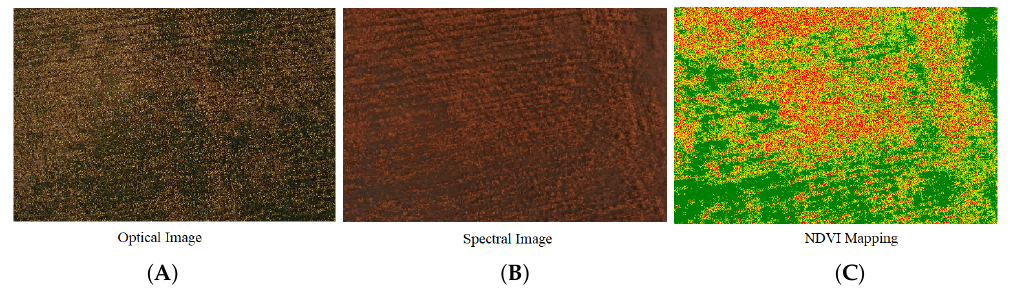
Figure 7. Wheat crop. ( A ) Optical image; ( B ) spectral image; ( C ) NDVI